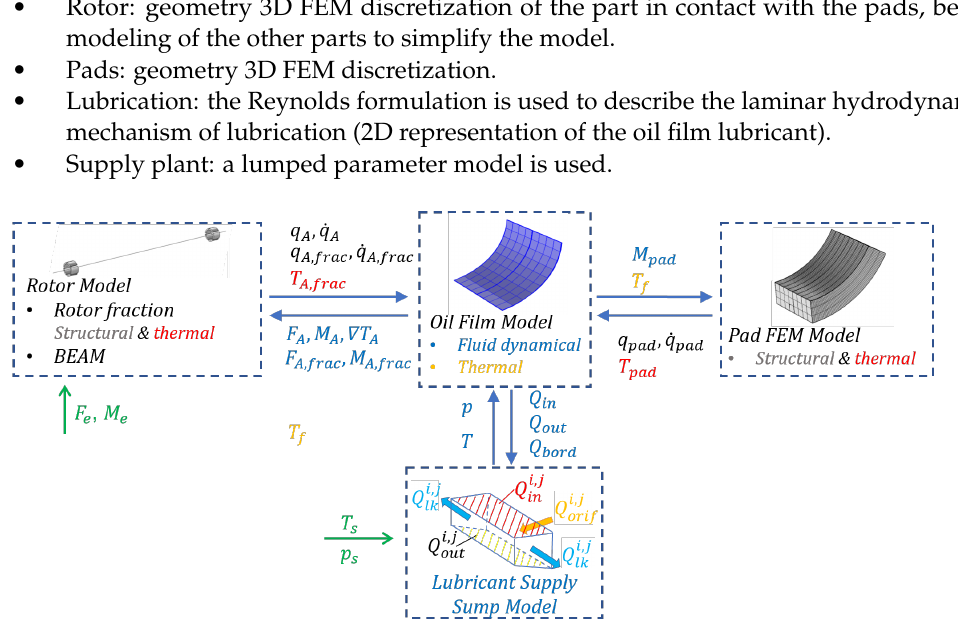
Figure 1. Structure of the developed